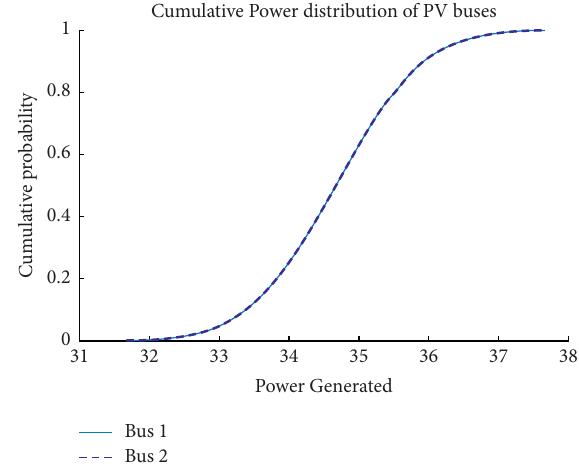
Figure 10: Cumulative power distribution at buses 1 and